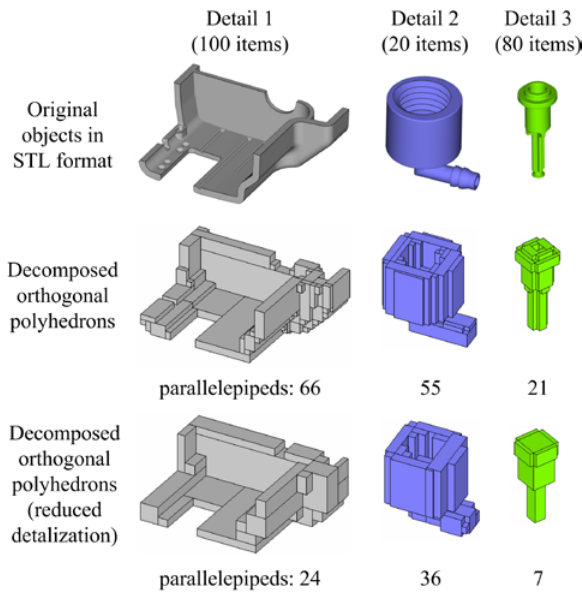
Fig. 10. Parameters of details .